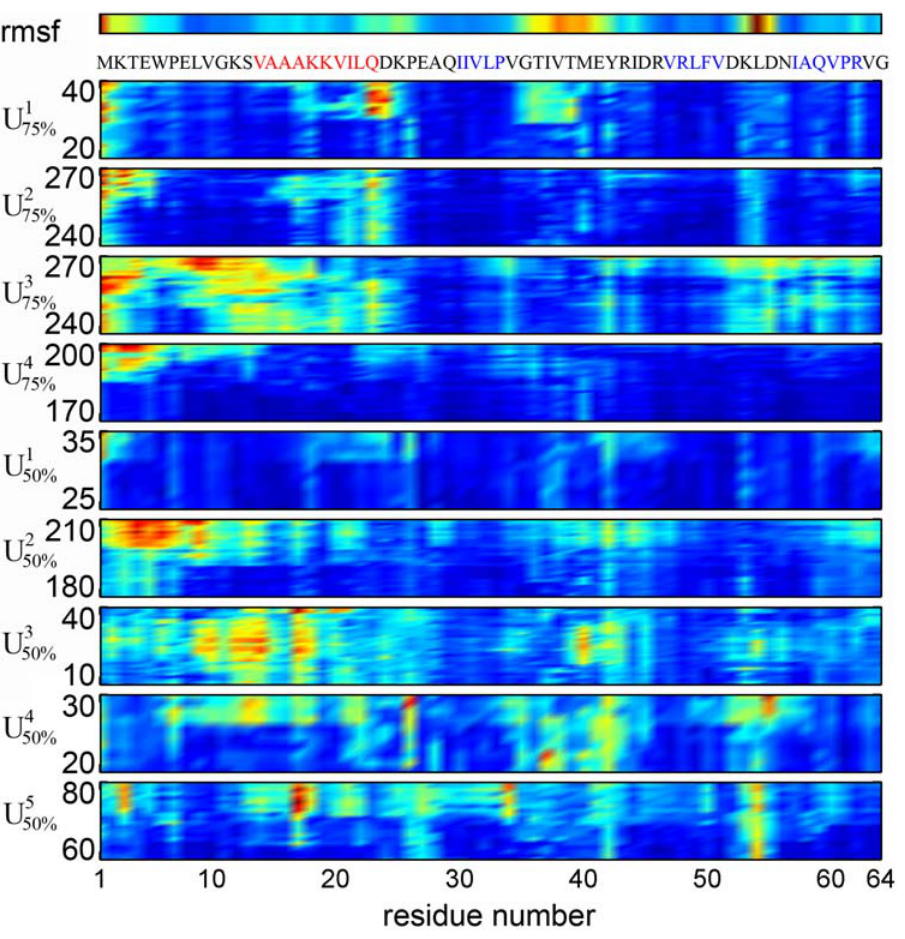
Figure 5. Per-residue C a -RMSD in the initial unfolding phases. Blue corresponds to low, red to high RMSD. The numbers on the left denote the start and end times of the respective displayed trajectory segment in ns. Top row: root-mean-square-fluctuations per residue in the native state. In the one-letter sequence code below, red marks the a -helix and blue b -strands.